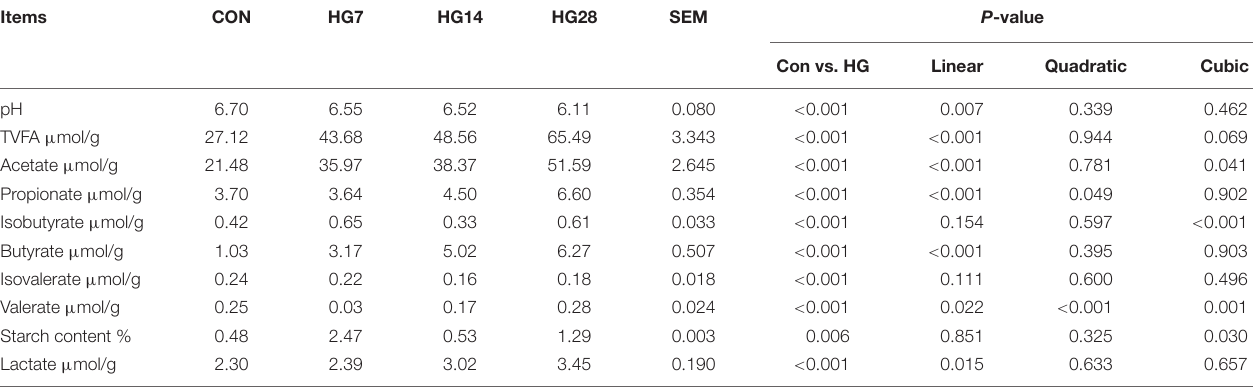
TABLE 1 | Colonic pH and concentrations of volatile fatty acid (VFA) in colonic digesta of sheep fed hay (CON) and high grain diets (HG 7–28) a . Items CON HG7 HG14 HG28 SEM